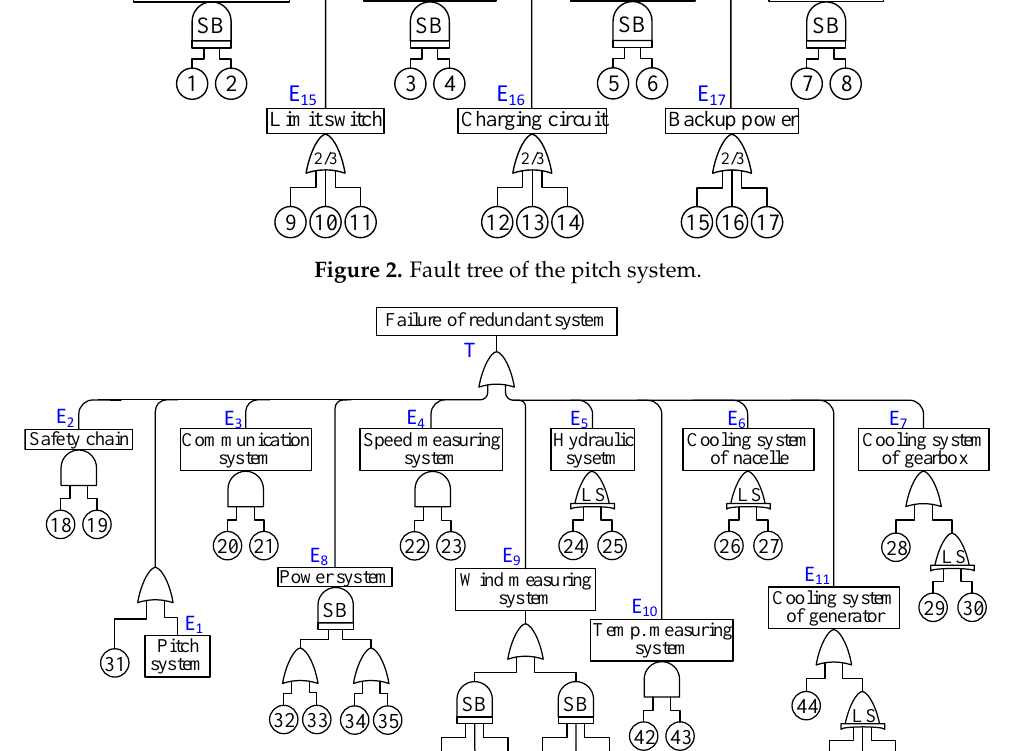
Figure 3. Fault tree of the redundant